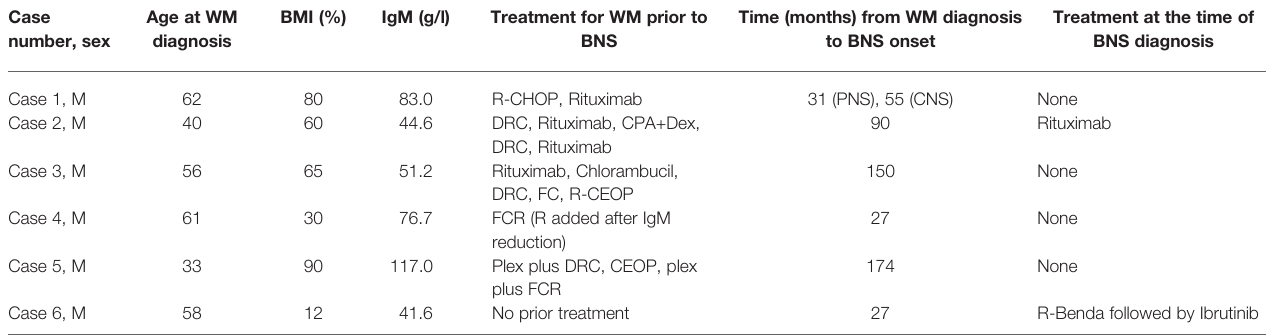
TABLE 1 | Summary of WM disease